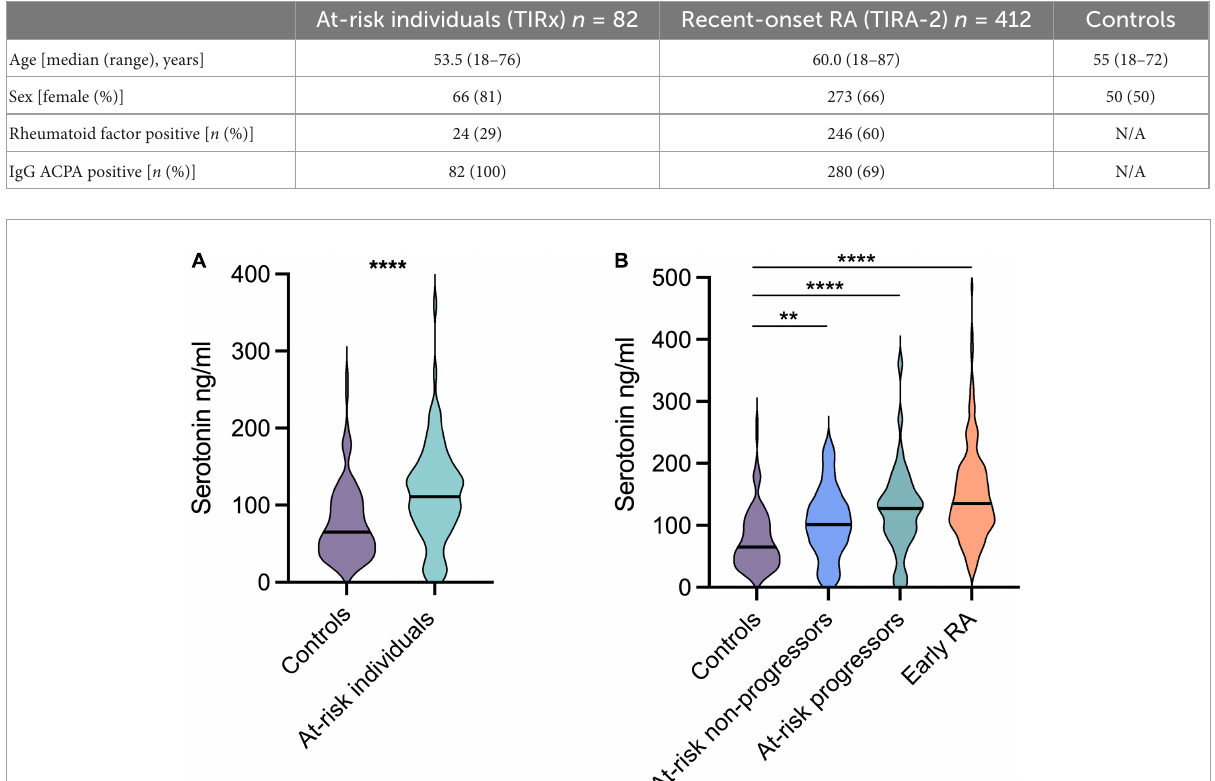
TABLE 1 Baseline characteristics of study participants.